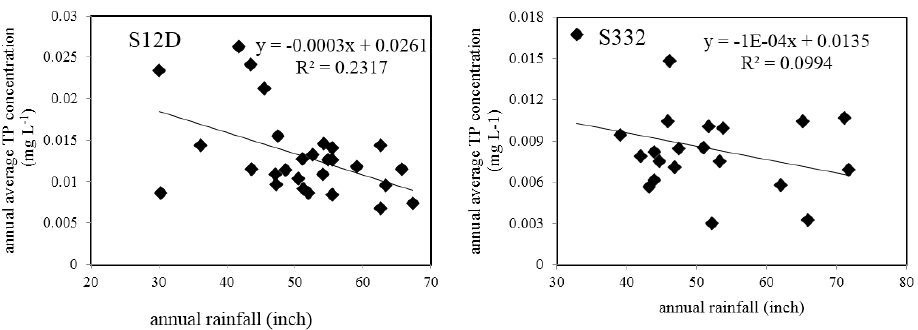
Figure 7. Rainfall trend at S12D and S332.